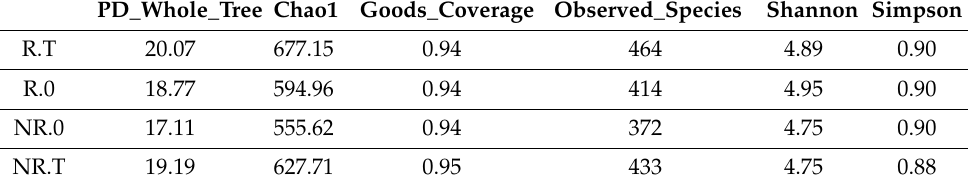
Table 3. The indices of α -diversity analysis.